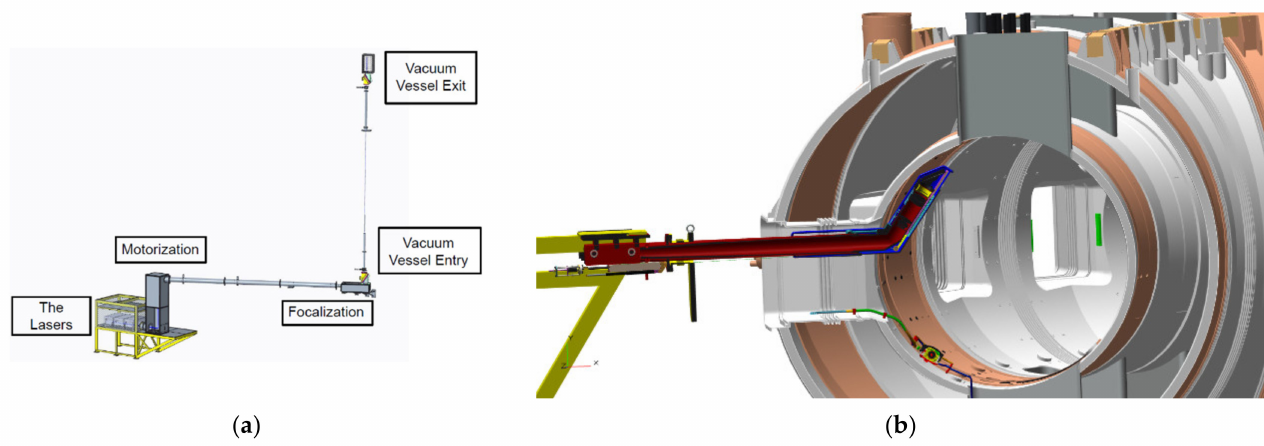
Figure 1. ( a ) Laser path. ( b ) Sectional view of the WEST tokamak, including the Thomson scatter- ing diagnostic.